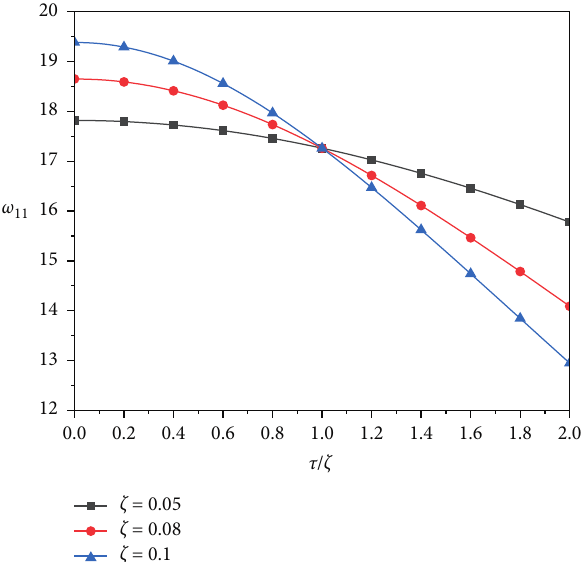
Figure 11: Variation of the first-order vibration frequency with respect to the ratio of the nonlocal parameter to the material characteristic scale parameter.